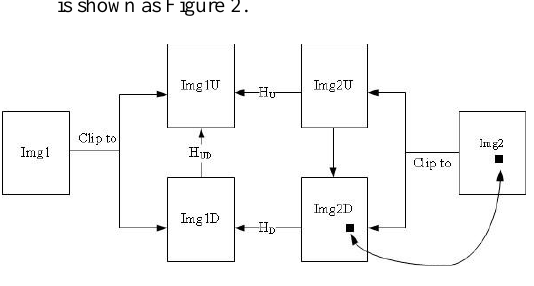
Figure 2. Method of clipping